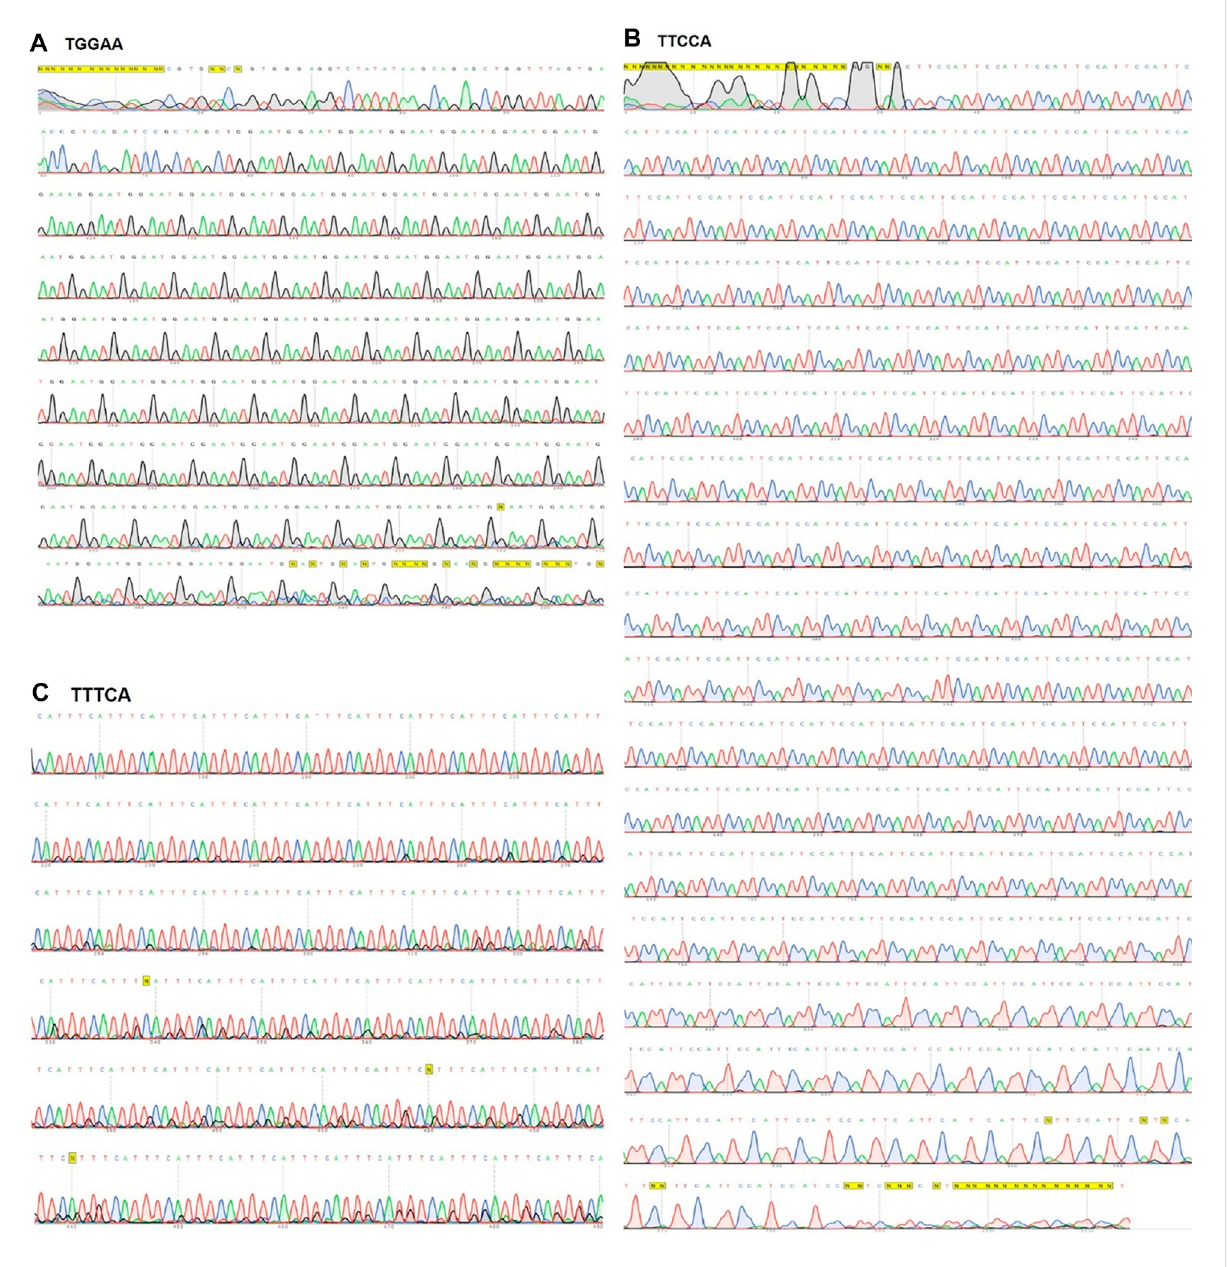
FIGURE 2 Sanger sequencing result for SCA31 and BAFME1 repeats. (A) TGGAA — Up to 500 bp sequence from the 5 ′ side of a plasmid containing 2.5 kb SCA31 insert was con fi rmed by Sanger sequencing. (B) TTCCA — Up to 1 kbp sequence from the 3 ′ side of the SCA31 plasmid was con fi rmed by